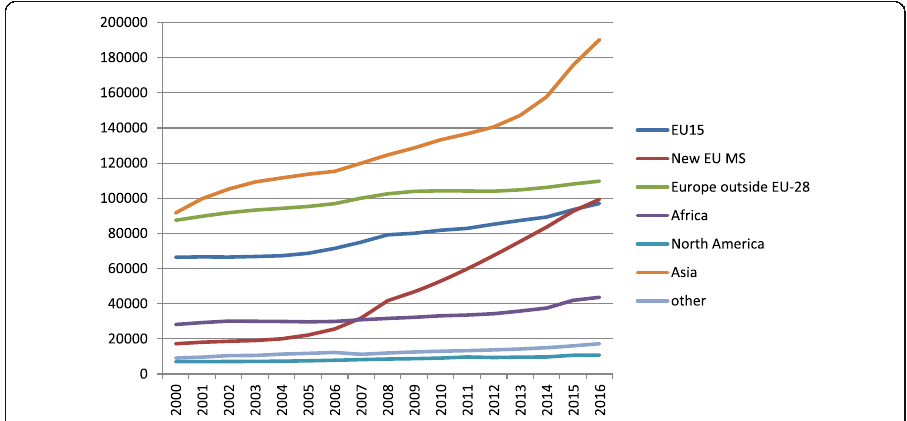
Fig. 1 First-generation immigrant population in Denmark, 2000 – 2016, by broad area of origin. Source : Statistics